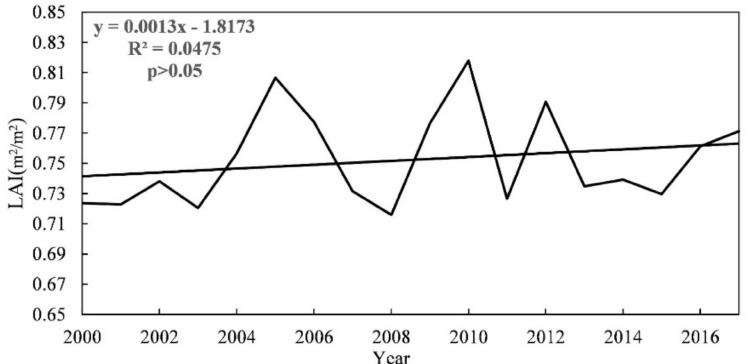
Figure 4. Line chart of mean leaf area index (LAI) during the vegetation growing season from 2000 to 2017 in the TRSR.